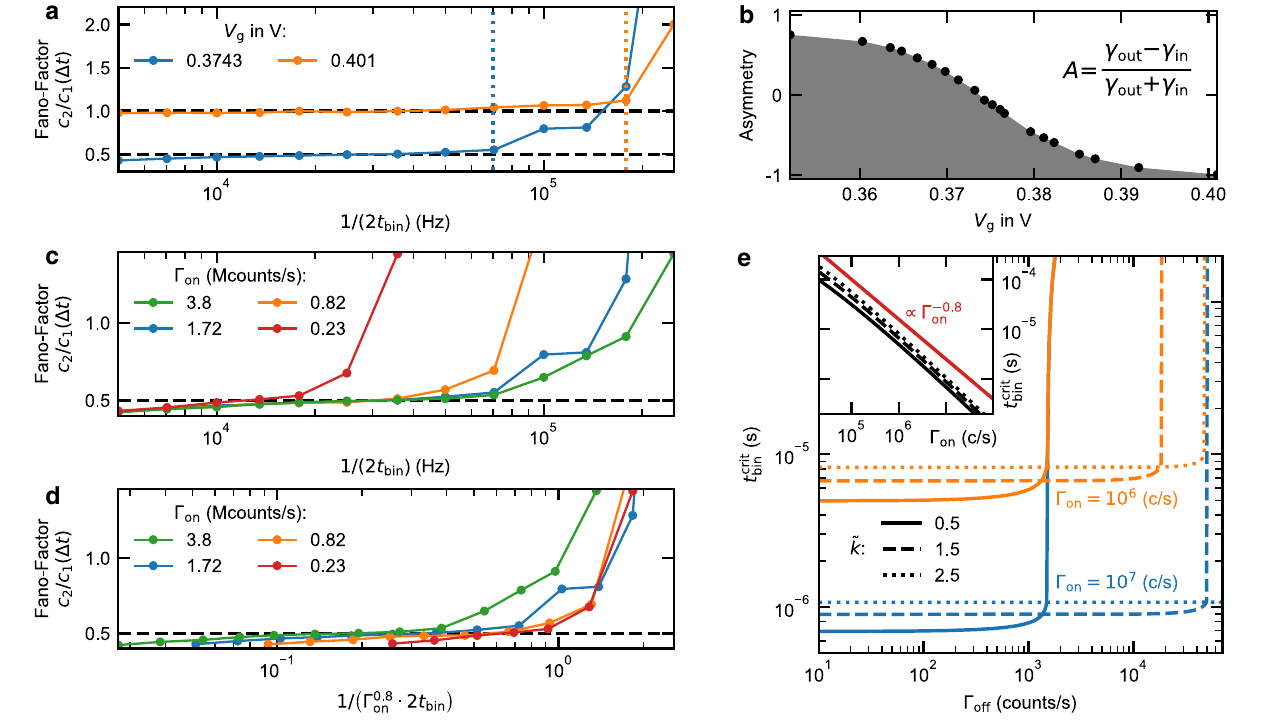
Figure 4. Fano factor as a function of 1 / t bin . ( a ) The Fano factor in dependence of t bin at different bias voltages V g . The Fano factor is used here as very sensitive indicator for an appropriate choice of the binning rate (bandwidth), as the Fano factor corresponds to the expected value for low binning rates and diverges for higher rates. The transport statistics can be evaluated up to 70 kHz (0.3742 V; dotted blue line) and 175 kHz (0.401 V; dotted orange line). ( b ) The asymmetry as a function of bias voltage is given by the tunneling rates that were determined in the waiting time distributions in Fig. 2. ( c ) The strong increase of the Fano factor can be shifted by changing the laser intensity and thus the average photon rate of the on state Ŵ on . ( d ) By rescaling the binning rate, the results for 0.23 Mcounts/s, 0.82 Mcounts/s, and 1.72 Mcounts/s coincide. The data for 3.8 Mcounts/s are slightly shifted. ( e ) The critical binning time t crit bin , as obtained from the model, versus the mean photon rate of the off state. (Inset) The dependence of Ŵ on can be described by t crit bin ∝ Ŵ − 0.8 on (inset). The threshold photon number ˜ k at which the maximum binning rate can be obtained depends on the average photon rate of the off state Ŵ off (see solid, dashed and dotted